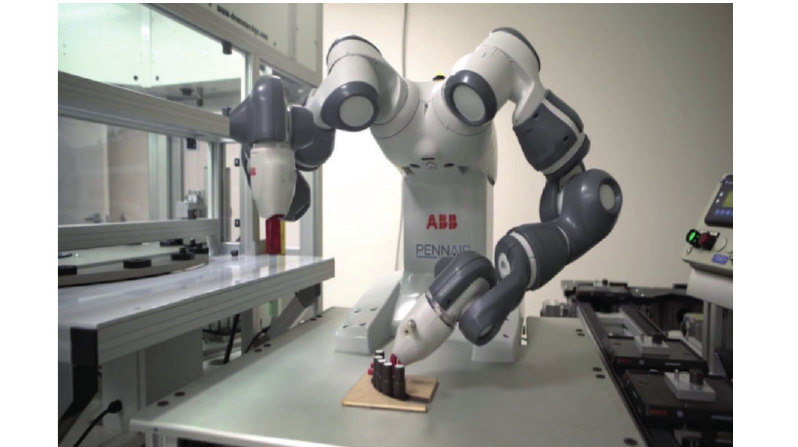
Figure 3. Articulating medical robot handling infectious samples (Courtesy: ABB - Kurtz ersa – Ersa